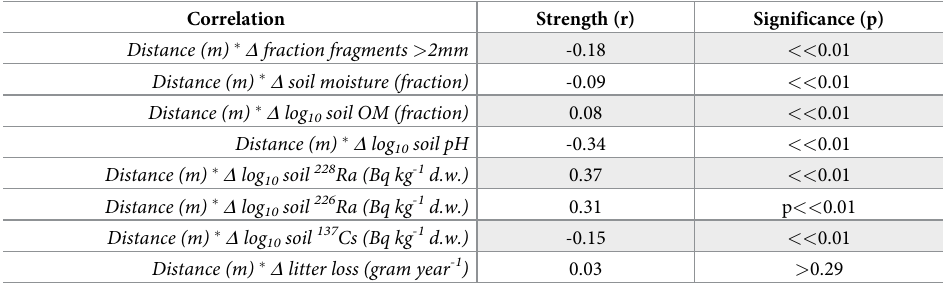
Table 1. Correlation strength and significance.